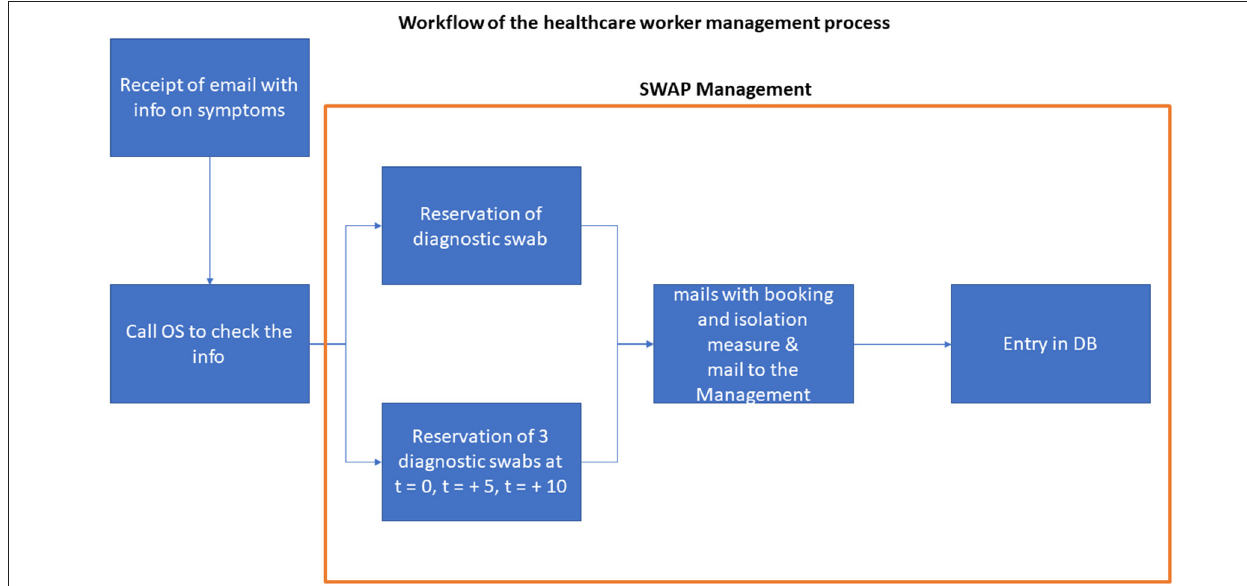
FIGURE 2 | Workflow of the healthcare worker management process with SWAPS.